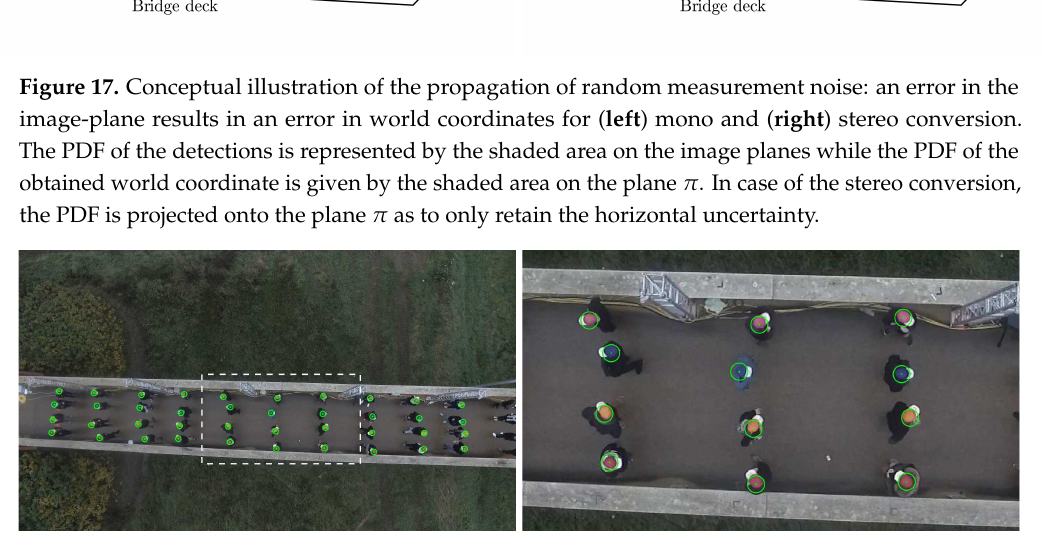
Figure 18. Random measurement error of the detection in the image plane: ( left ) snapshot of the drone camera with the white dashed line indicating the ( right ) corresponding zoom with indication of the 95% confidence regions of the detections considering measurement noise (green lines) and the true detection of the pedestrians (green dots).